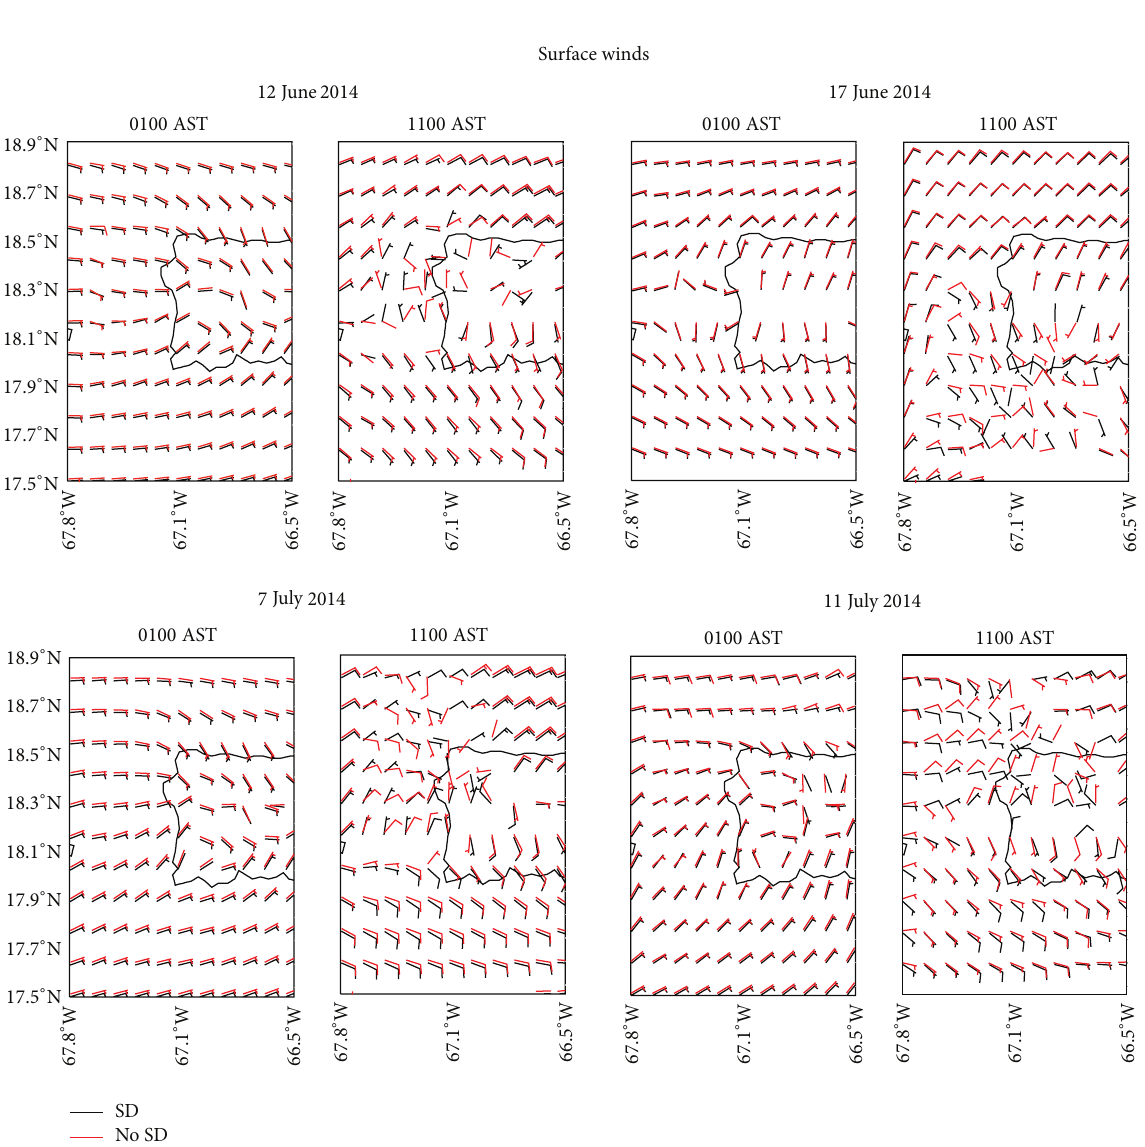
Figure 8: RAMS generated wind barbs near the surface at two different times (0100 and 1100 AST) for all runs. Black barbs denote SD results, and red barbs denote no SD